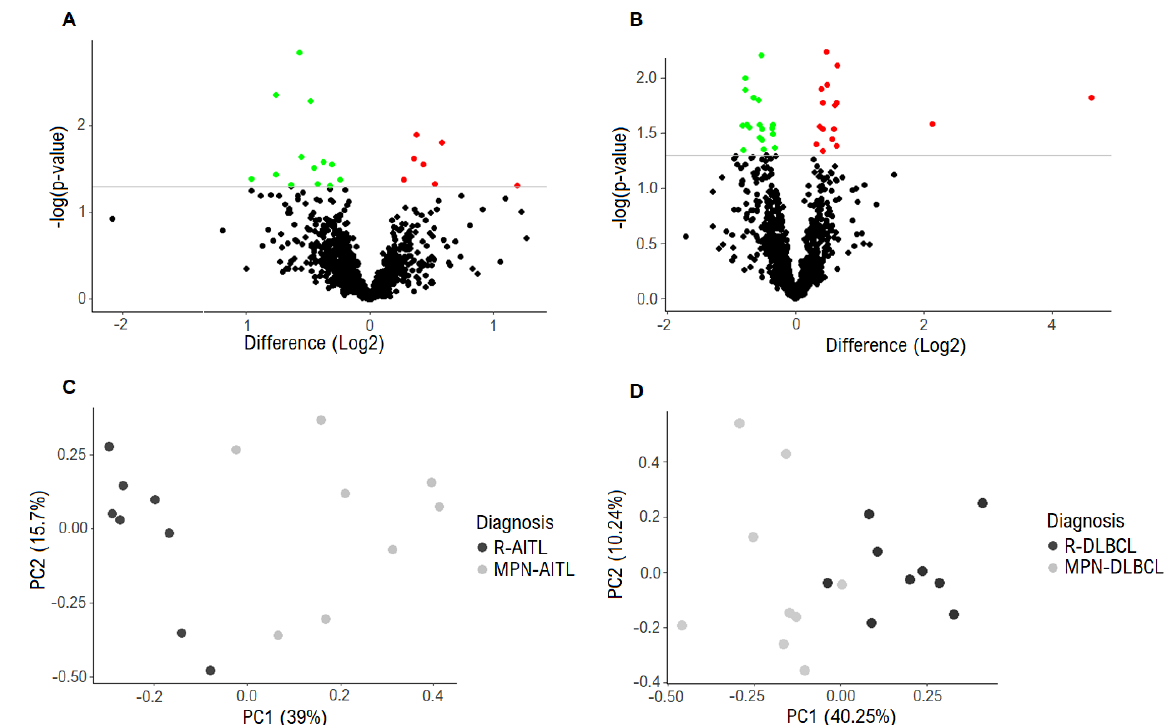
Figure 1. Differentially expressed proteins. ( A ) Proteomic analysis revealed 20 significantly differentially expressed proteins between the MPN-AITL and R-AITL biopsies. The grey horizontal line marks the threshold of p < 0.05 of significantly expressed proteins. Green: downregulated. Red: upregulated. ( B ) Proteomic analysis showed 34 significantly differentially expressed proteins between the MPN-DLBCL and R-DLBCL biopsies. The grey horizontal line marks the threshold of p < 0.05 of significantly expressed proteins. Green: downregulated. Red: upregulated. ( C ) PCA with input of the 20 differentially expressed proteins revealed distinct clustering between the MPN-AITL and R-AITL specimens. Dark grey represents the R-AITL samples and light grey represents the MPN-AITL samples. ( D ) PCA with input of the 34 differentially expressed proteins showed clustering between the MPN-DLBCL and R-DLBCL specimens, with the exception of two samples. Dark grey represents R-DLBCL samples and light grey represent MPN-DLBCL samples. Abbreviations: AITL, angioimmunoblastic T-cell lymphoma; DLBCL, diffuse large B-cell lymphoma; MPN, myeloproliferative neoplasia; PCA, principal component analysis; R-, reference sample.